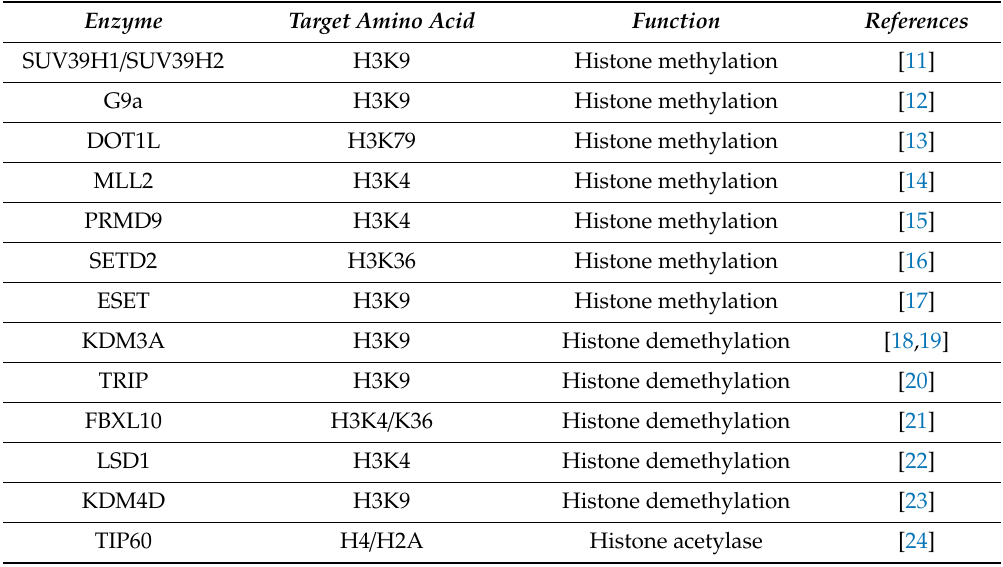
Table 1. Histone PTMs and related histone-modifying enzymes described in